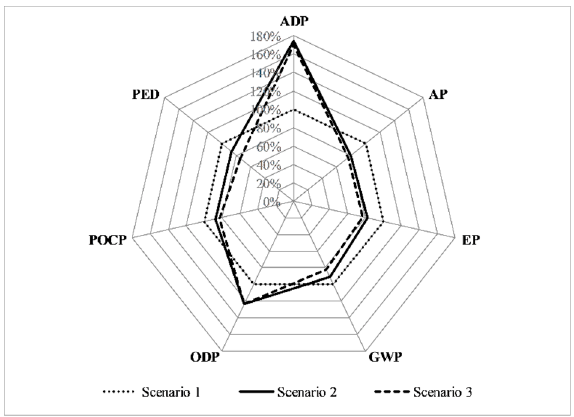
Figure 8. Impact assessment results.